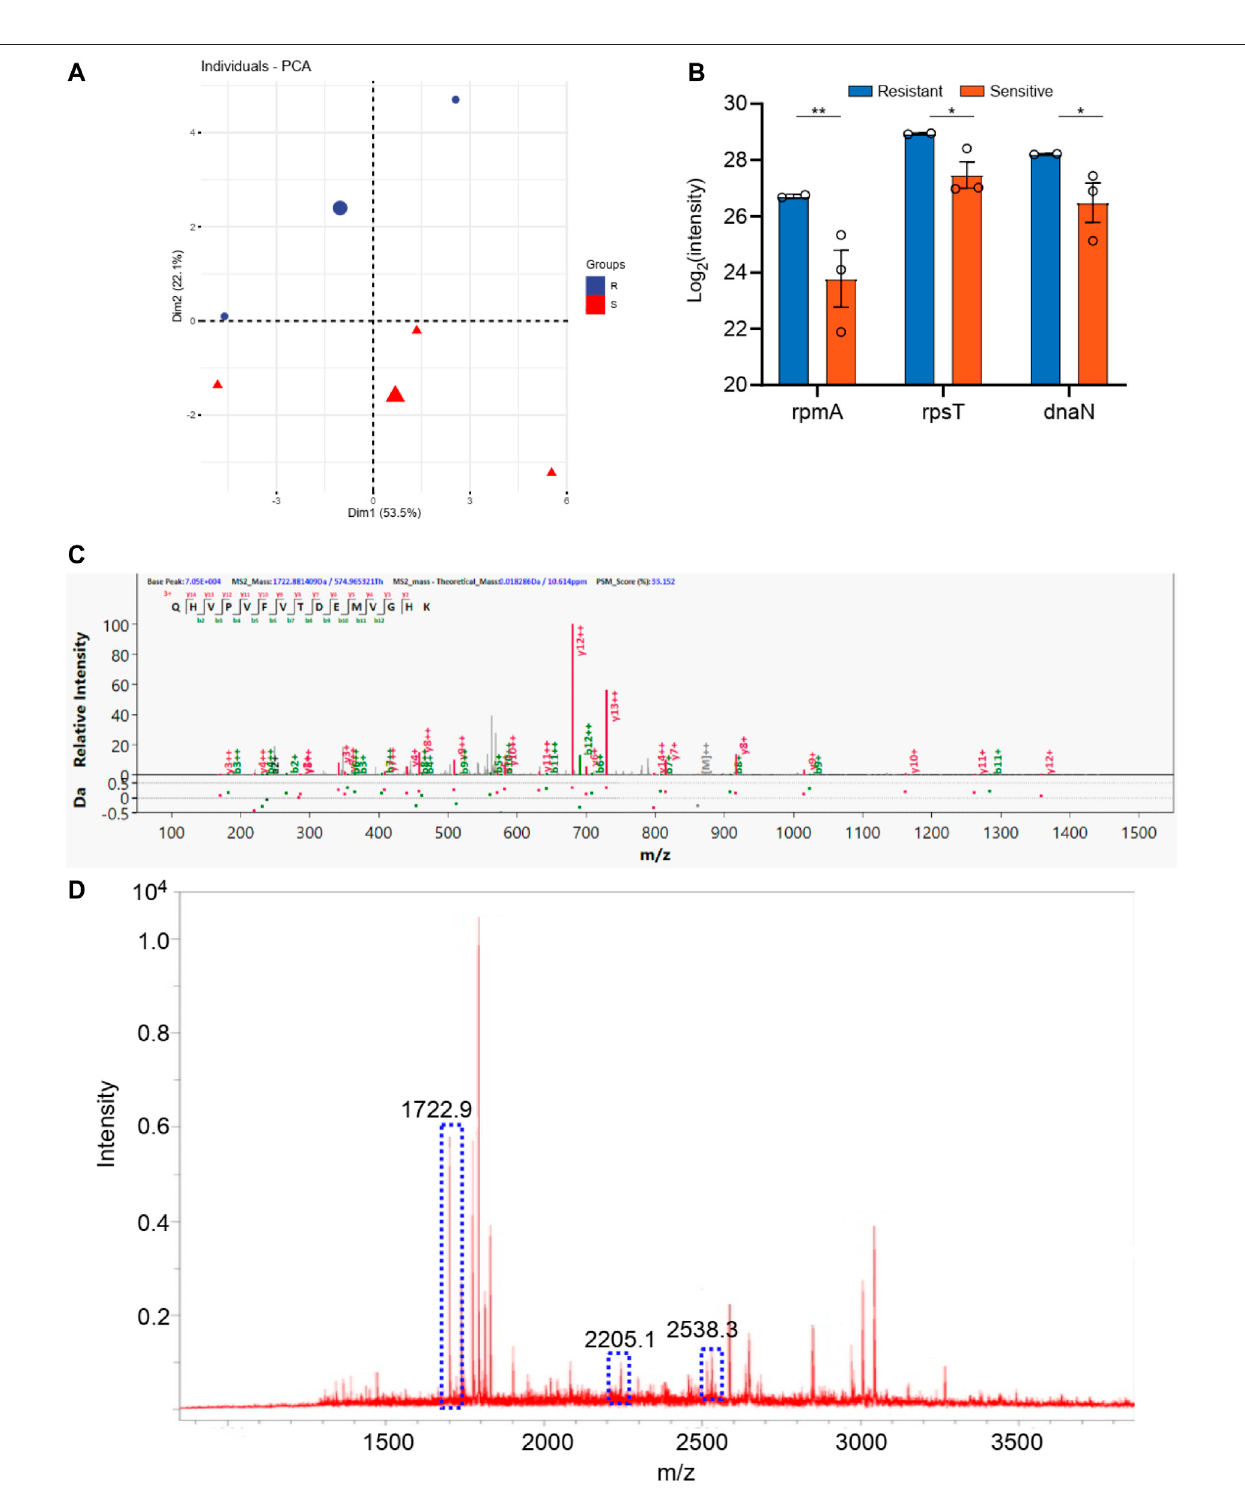
FIGURE 5 | (A) The PCA analysis of drug resistance of levo fl oxacin for Staphylococcus aureus ; (B) The differential proteins between drug resistance group and drug sensitive group; (C) The corresponding differential peptides and (D) the fi nger print in MALDI TOF.